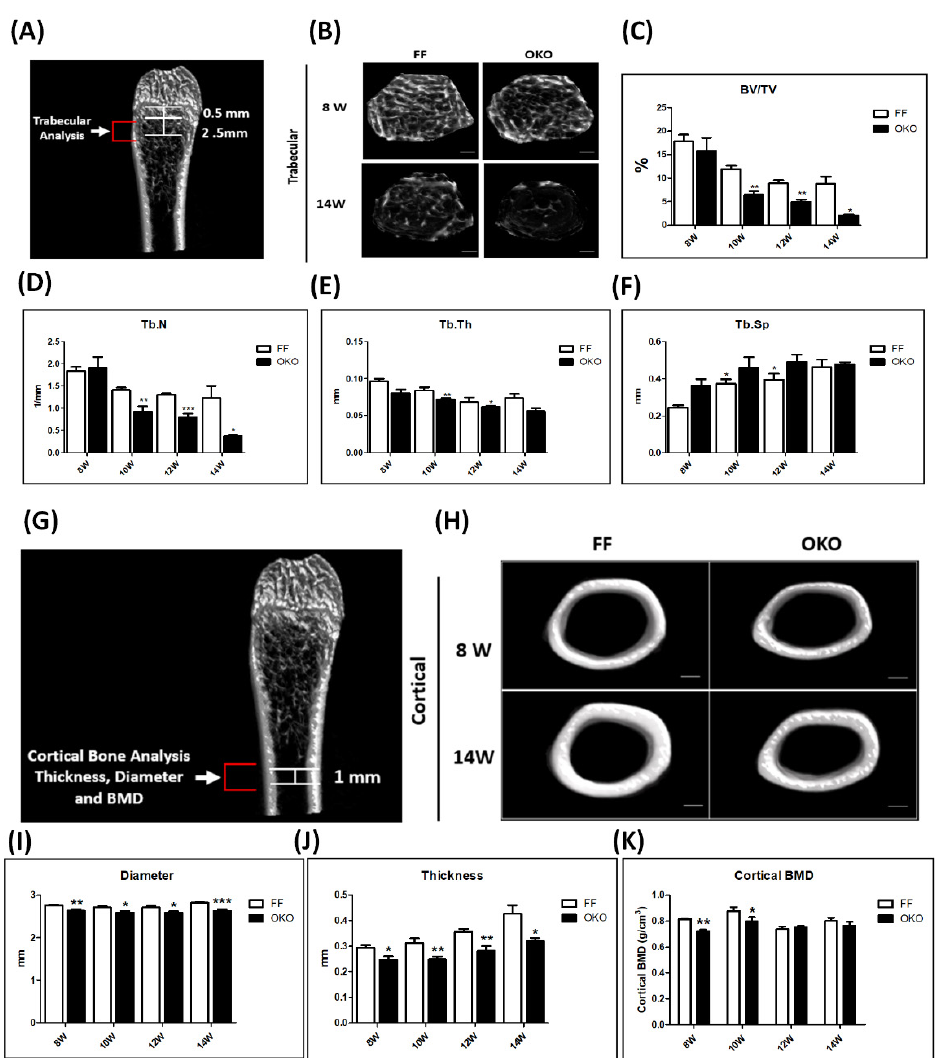
Figure 2. Deletion of DDR1 in osteoblasts/osteocytes decreased cancellous bone volume in femur trabecular bone and showed a thinning cortical bone in the femur. ( A ) The region of the trabecular bone cross section includes evaluating 2.5 mm of the trabecular bone starting at 0.5 mm below the growth plate. The representative Micro-CT images of the distal femoral of FF/OKO mice. ( B ) The